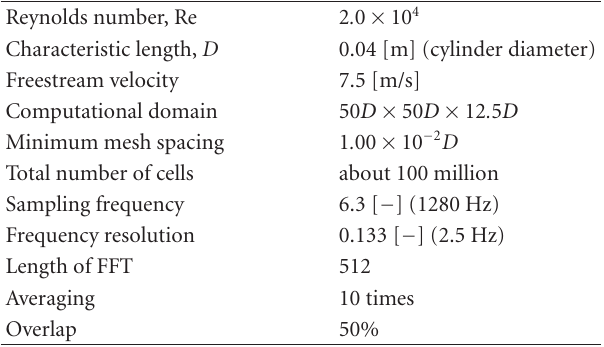
Table 1: Computational condition of a circular